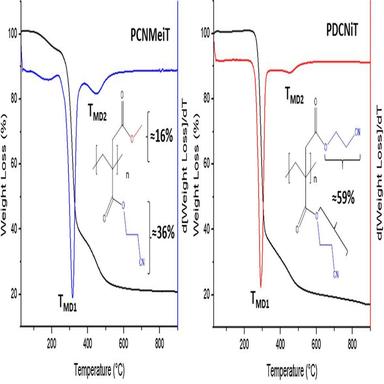
TGA and DTGA curves for PCNMeiT and PDCNiT.